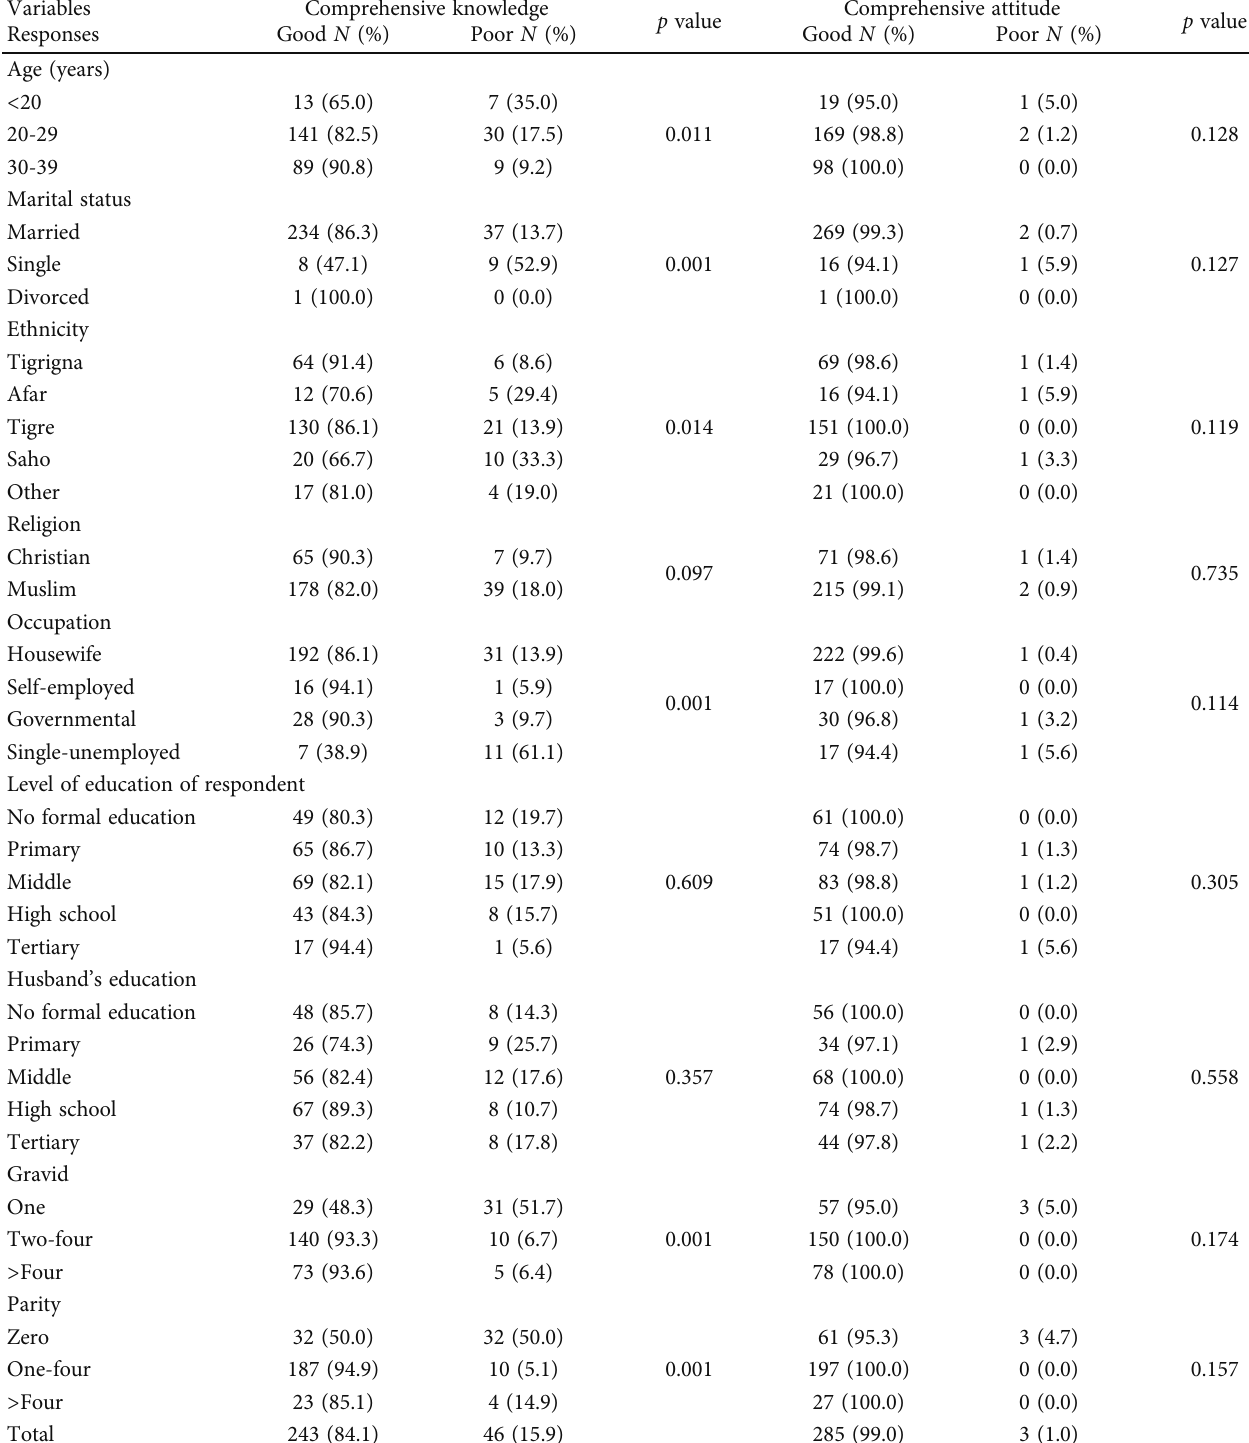
Table 5: Association between background of pregnant women and level of knowledge and attitude in Amatere Health Center, Massawa.